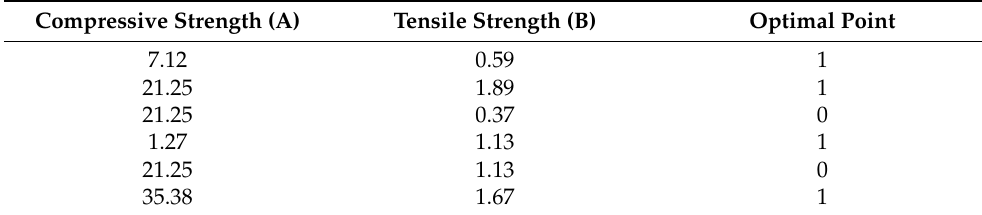
Figure 10. Normal probability plot of compressive strength (X1). Figure 11. Pareto chart of optimal points for compressive (A) and tensile (B) strength.